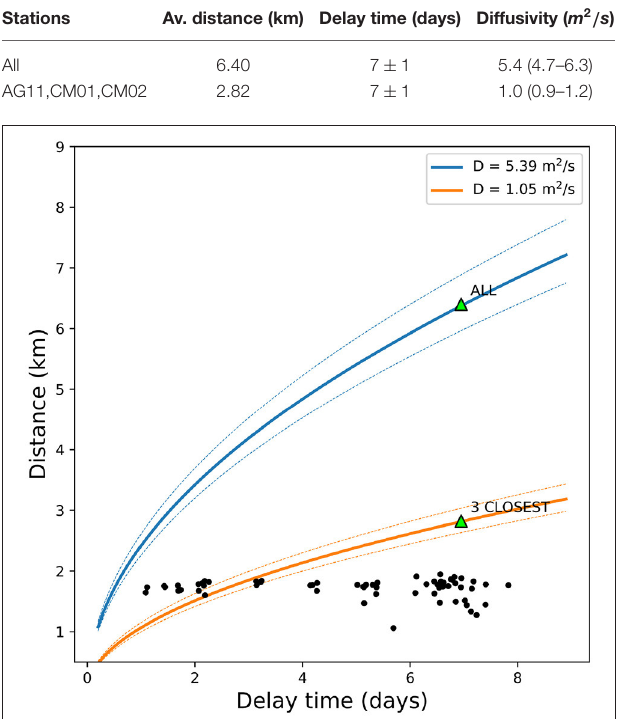
FIGURE 10 | Colored lines: triggering front computed from diffusivity values estimated from Equation (2) for station AG11 and CM02 (green triangles). Diffusivity values are reported in the legend. Black dots: seismicity recorded in June 2006 during the first injection tests ( Improta et al., 2017), plotted as a function of delay time and distance from the injection